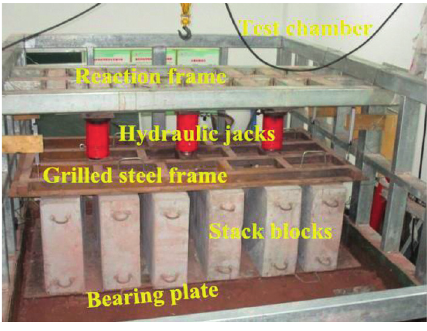
Figure 2: Loading